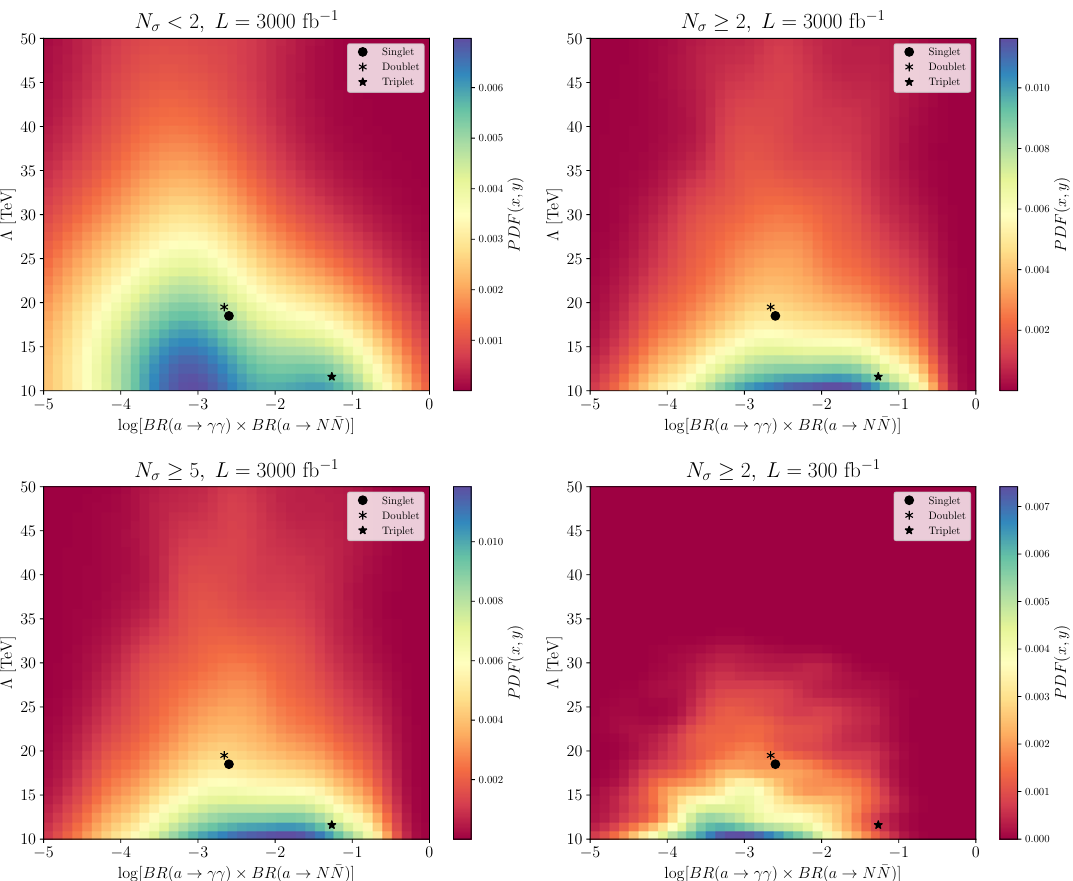
Figure 6 . Heat maps in the plane BR ( a ! (cid:13)(cid:13) ) BR ( a ! N (cid:22) N ) versus (cid:3). The points are more concentrated in the colder regions. We display the cases where L = 3000 fb (cid:0) 1 and N (cid:27) < 2( (cid:21) 2)[ (cid:21) 5] in the upper left(upper right)[lower left] panel, and the case L = 300 fb (cid:0) 1 and N (cid:27) (cid:21) 2 in the lower right panel. The dot, asterisk and star represent examples of a singlet, doublet and triplet representation of the UV complete model presented in section 5,